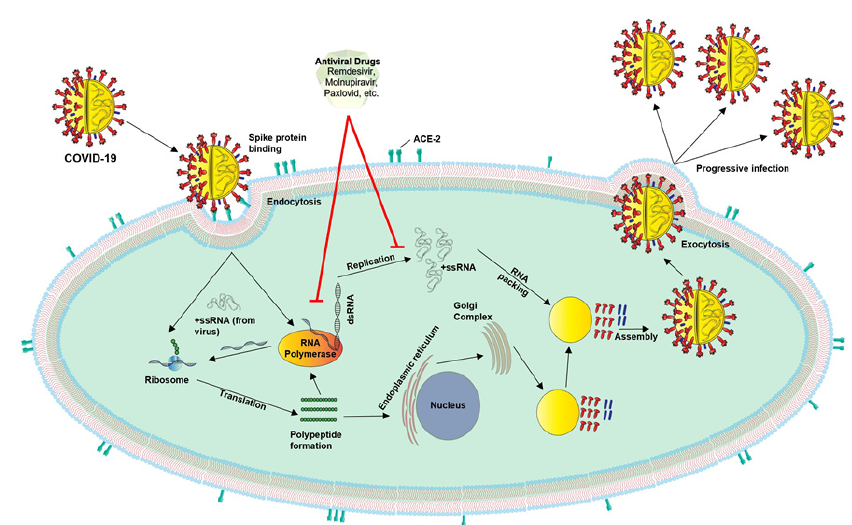
Figure 5. A diagrammatic representation illustrating cellular interaction of COVID-19; its replication process, assembly, release; and potential treatment options with antiviral drugs. COVID-19 virus enters the host through various means such as the inhalation of aerosol droplets. Then, the S1 subunit of the spike glycoprotein binds with the ACE-2 receptors (top left), which allows for viral ++ssRNA to be released into the host cell, where it employs cellular machinery to produce its RNA polymerase, its genetic material, and proteins needed for the viral capsule (middle-to-bottom left). Excluding the enzymatic and genomic components, other components are processed using endoplasmic reticulum and the Golgi complex (bottom middle). The viral ++ssRNA copies are then brought together and assembled with other viral components (middle bottom right). The newly produced virus exits the cell through exocytosis, where it can go on to infect more cells (top right). Antiviral drugs (top middle) such as Remdesivir, Molnupiravir, and Paxlovid are thought to disrupt this replication process, thus inhibiting disease progression.